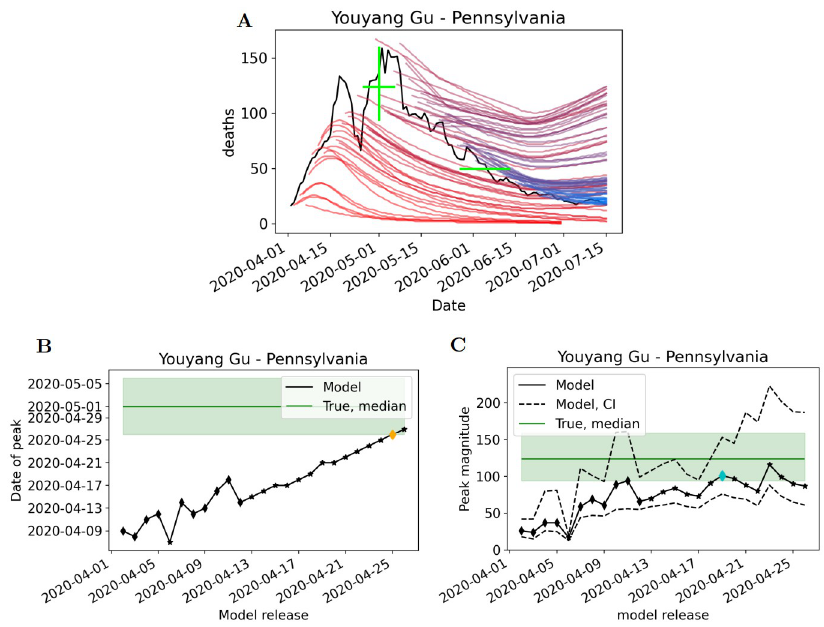
Fig 4. Multi-release and ‘convergence plots’ of the YYG forecast of Pennsylvania’s peak during Spring 2020. A) The multi-release plot demonstrates the YYG forecasts from April 2020 through July 2020. Red lines indicate early model releases; blue lines indicate later model releases; purple are intermediate. Green lines represent uncertainty in true peak date/magnitude and black line is the seven-day rolling average. B) The convergence plot for peak date demonstrates the uncertainty in true peak date (green shaded region; median provided for reference) and the YYG predictions of the peak date for each model release leading up to the peak. C) Corresponding plot for peak magnitude. The blue diamond represents first release the prediction was inside the green window ( PeakDate_FirstAccurate ) and the orange diamond represents the model is consistently inside the window of peak date/magnitude from that release onwards ( PeakDate_FirstConsistent